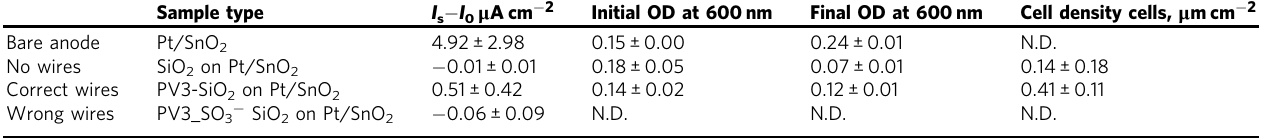
Table 1 Current density and bacterial cell